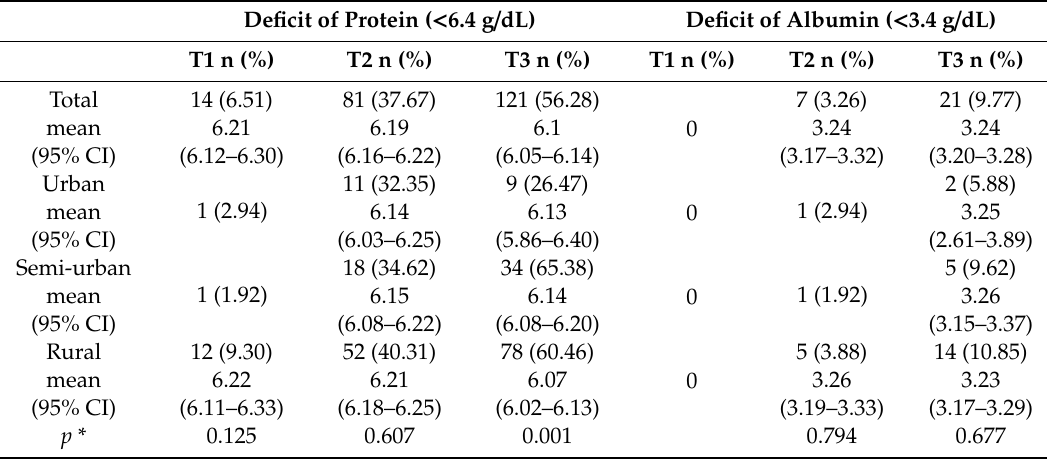
Table 3. Prevalence of low plasma total proteins and low albumin in the study.